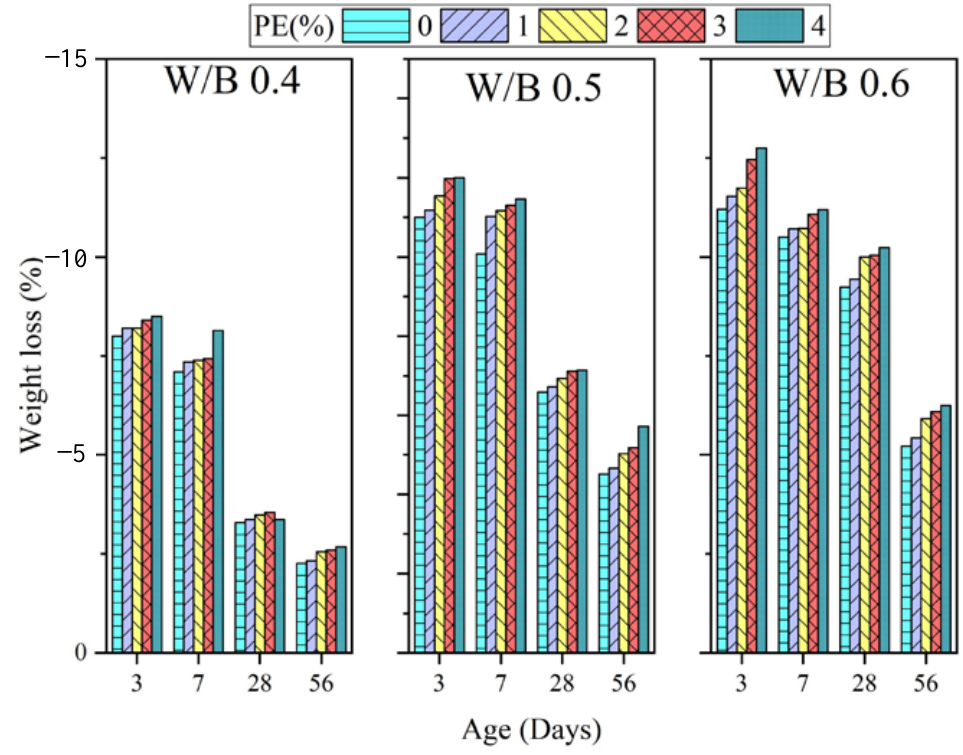
Figure 11. Resistance to sulfate attack of cement mortar with different W/B ratios and waste PE.